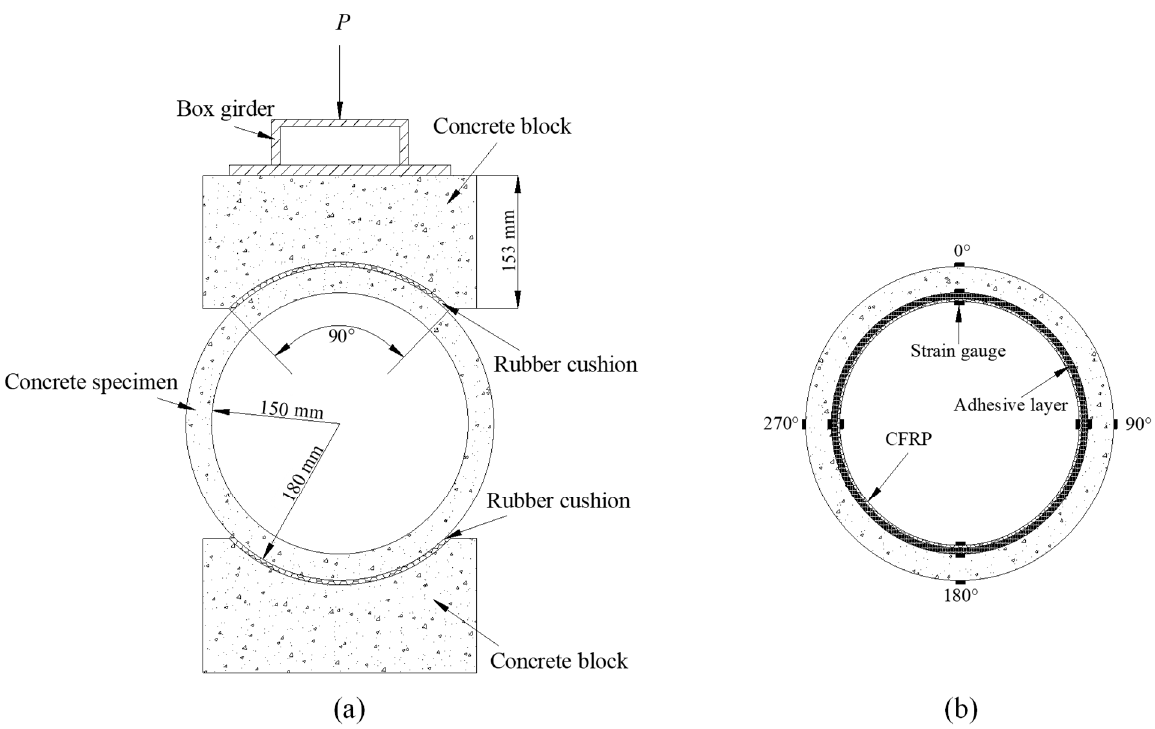
Figure 6. Details of the experimental test: ( a ) device; ( b ) strain gauge positions.